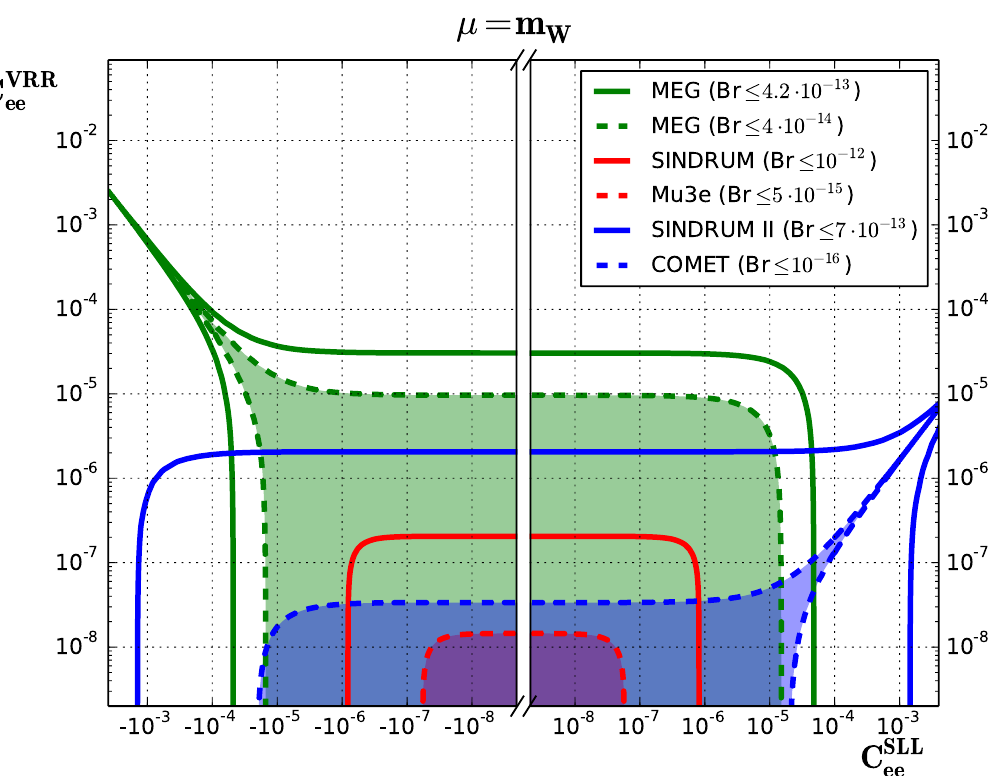
Figure 3. Allowed regions in the C S LL (cid:22) ! e conversion (blue) for current (straight) and future (dashed) experimental limits.